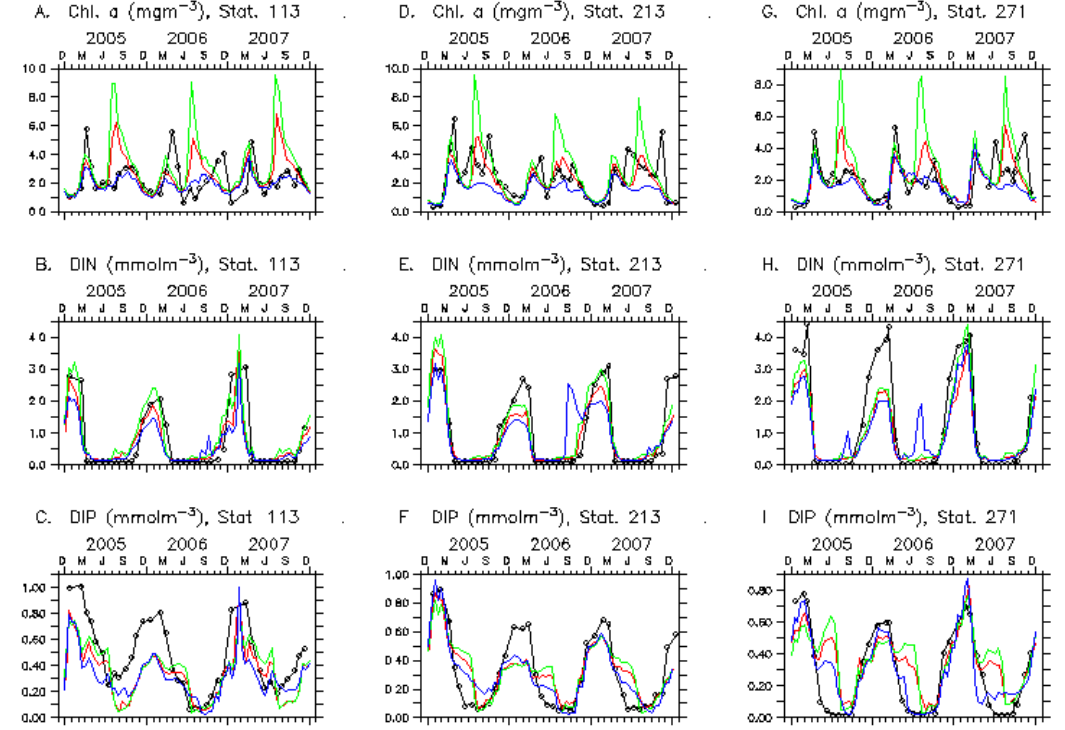
Fig. 2. Comparison of surface model results among three experiments with observed data from offshore stations. Black dashed line is observed data, solid lines show model results of Cases NP16 (green), NP10 (red), and NP6 (blue). Abbreviations: Chl- a for chlorophyll- a , DIN for dissolved inorganic nitrogen, DIP for dissolved inorganic phosphorus, and Stat. 113 (Arkona Basin), Stat. 213 (Bornholm Basin), and Stat. 271 (Gotland Deep) (locations in Fig.